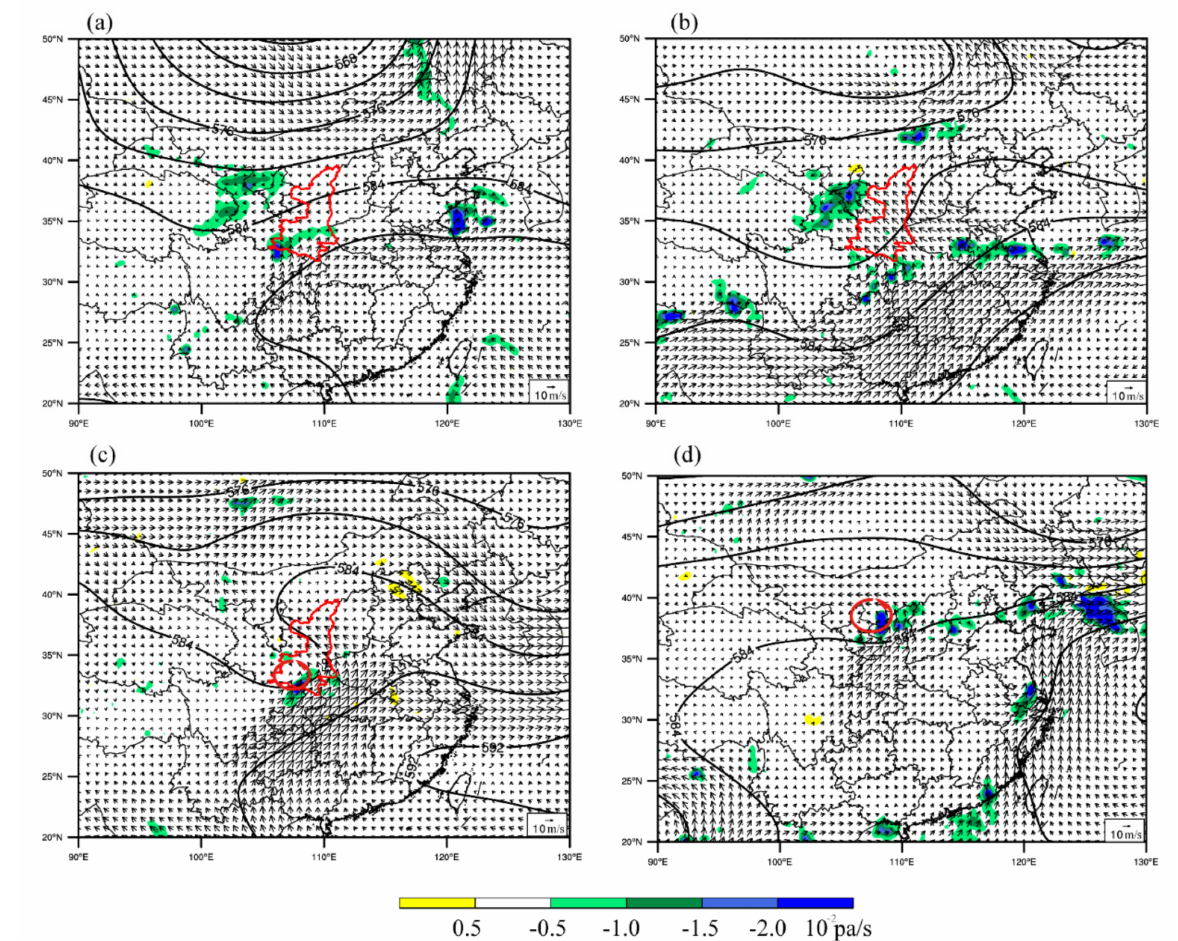
Figure 2. Examples of the classification of circulation of typical rainstorm weather patterns. ( a ) FGXFC, the time is 12:00 on 5 August 2020, ( b ) XFC, the time is 12:00 on 11 July 2020, ( c ) XNW, the time is 12:00 on 13 June 2020, and ( d ) DWQB, the time is 12:00 on 5 August 2020. Arrows: 850 hPa winds, contours: 500 hPa geopotential lines and shades: 700 hPa vertical velocity (10 − 2 Pa s − 1